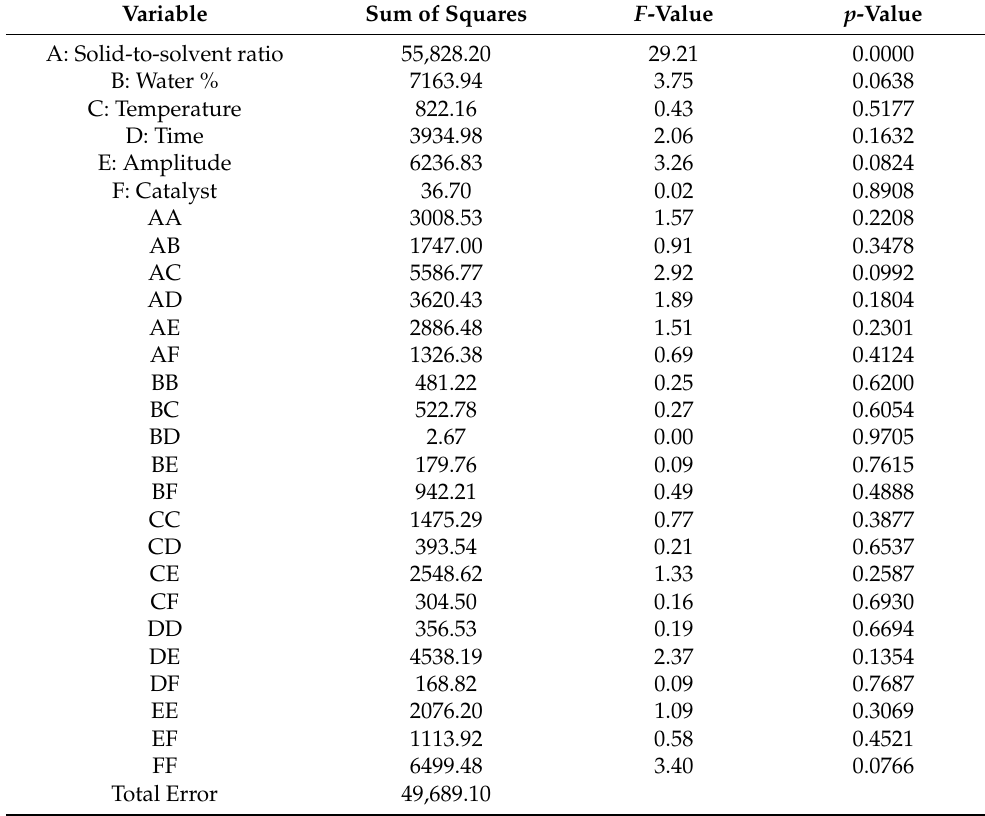
Table 2. Variance analysis of the quadratic model stepwise adjusted to the USE-based extraction of polyphenols from pine